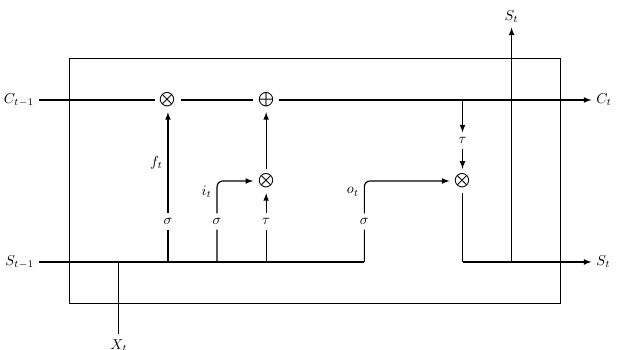
Figure 5. Example of a LSTM’s memory block, where f t , i t , o t mean forget, input, and output gates, respectively; τ and σ represent the tanh and sigma activation functions of [30].